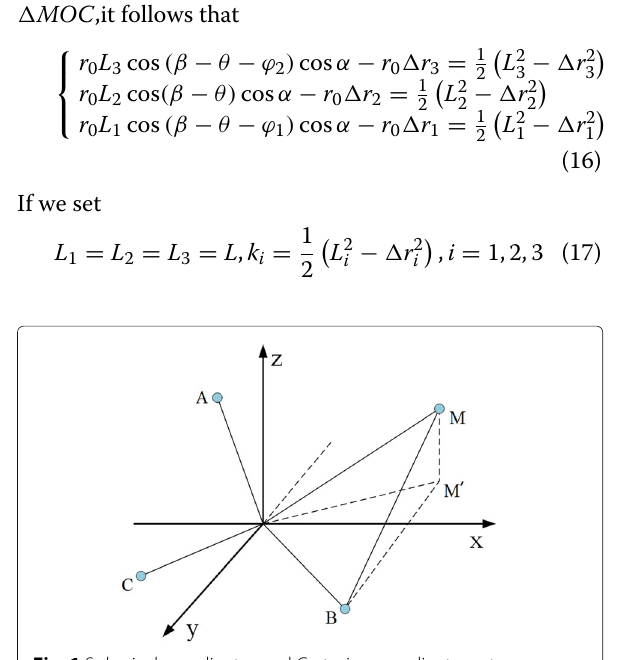
Fig. 1 Spherical coordinates and Cartesian coordinate